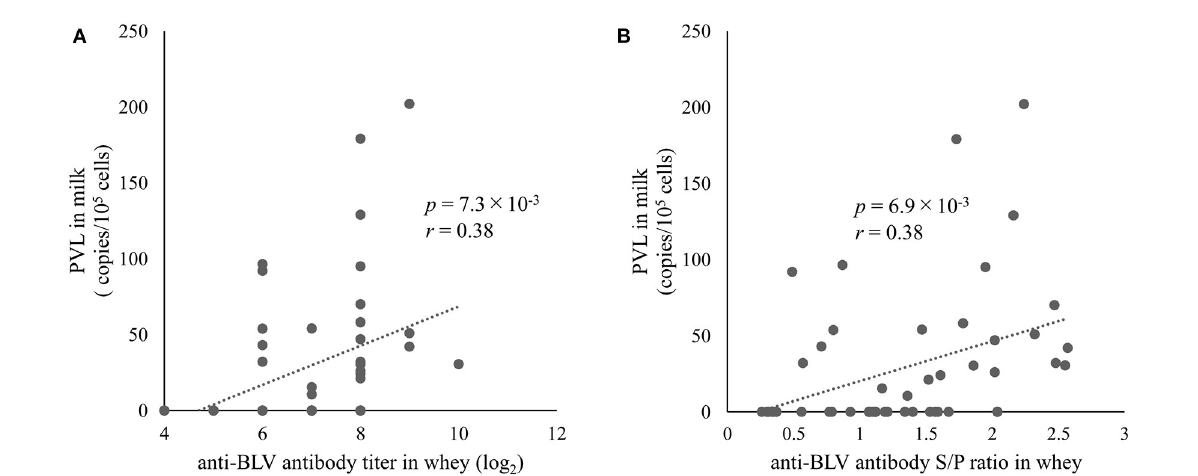
FIGURE4 The correlation between anti-bovine leukemia virus (BLV) antibody in whey and BLV proviral load (PVL) in milk. Anti-BLV antibody titers and S/P ratios at 32-fold dilution in whey were measured using an anti-BLV antibody ELISA. The PVLs in milk were measured using the CoCoMo-qPCR-2 method (RIKEN Genesis, Kanagawa, Japan). (A) The correlation between anti-BLV antibody titer in whey and BLV PVL in milk ( n = 49). (B) The correlation between anti-BLV antibody S/P ratios at 32-fold dilution in whey and BLV PVL in milk ( n = 49).